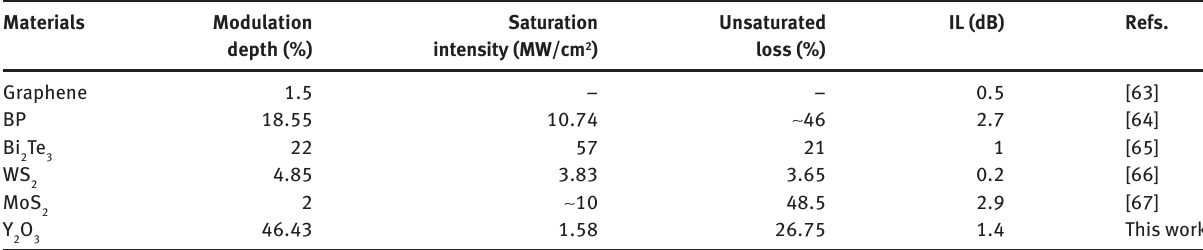
Table 1: Nonlinear behavior of some SAs. Materials Modulation